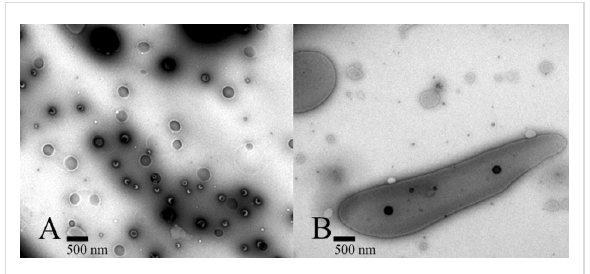
Figure 5: TEM images of α -CD-disiloxane 4 (A) and the supra- molecular formation of α -CD-disiloxane 4 with ferrocene (B).